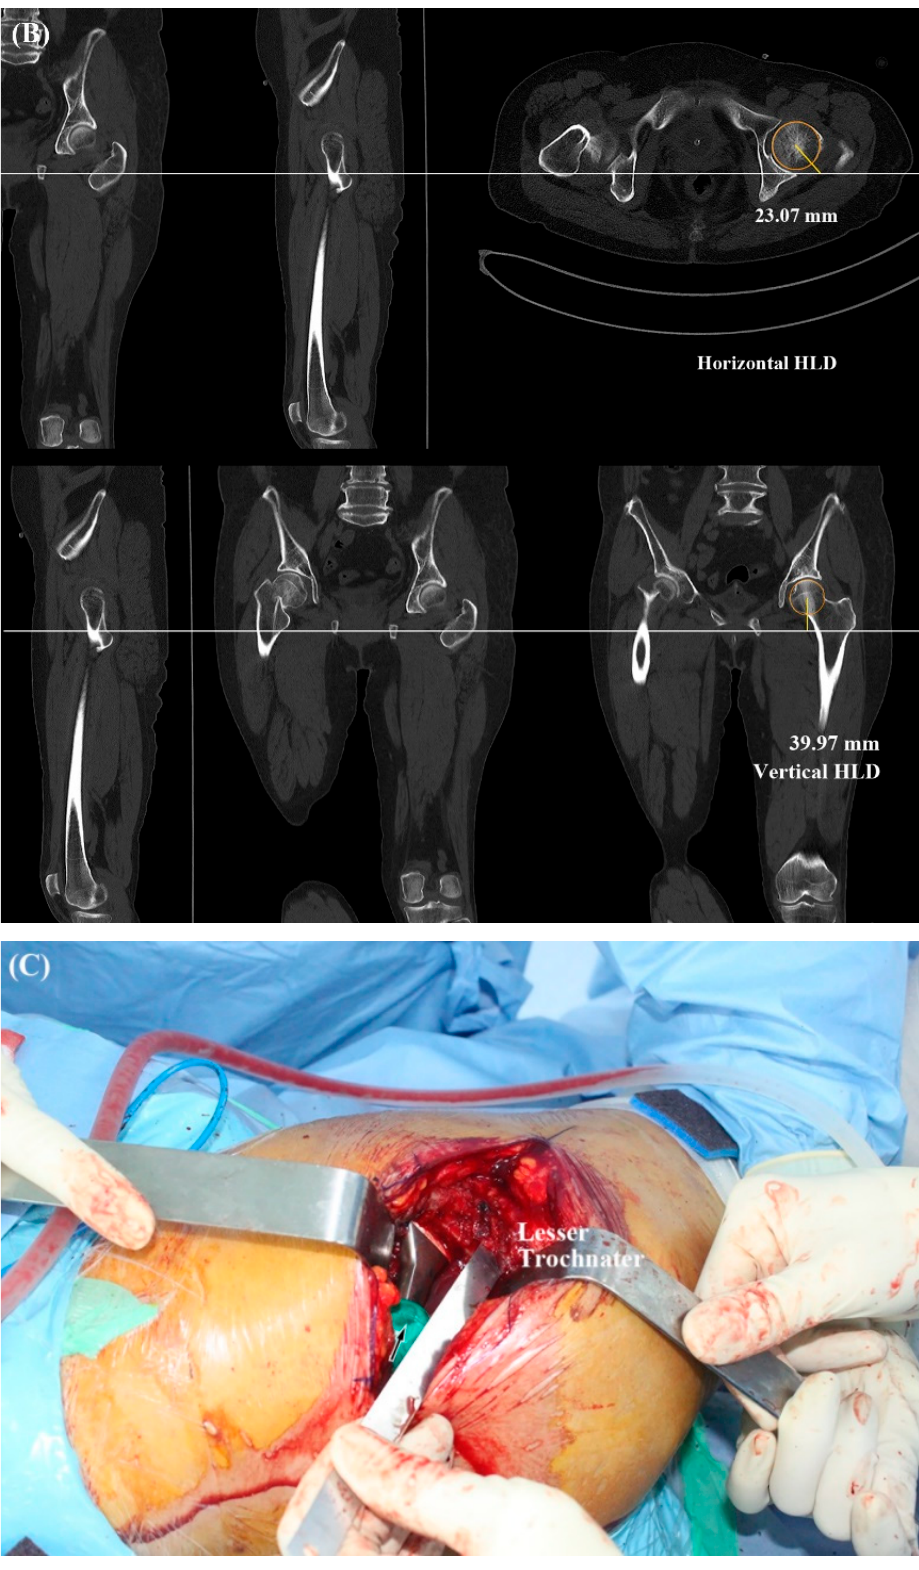
Figure 5. Three-dimensional head-lesser trochanter distance (3-D HLD) was calculated using the Pythagorean theorem with the horizontal HLD and vertical HLD as variables ( A , B ). Adjust the modular neck system to match 2-D or 3-D HLD measurements ( C ).